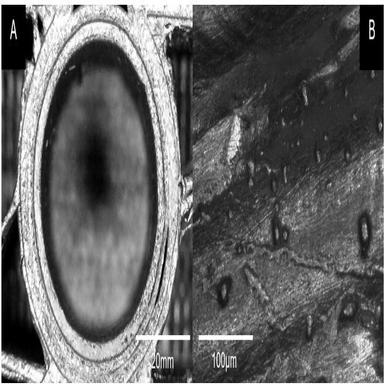
Initial deposition of (A) a 40 mm diameter hole and (B) initial deposition spatter features produced as a result of the manufacturing process.